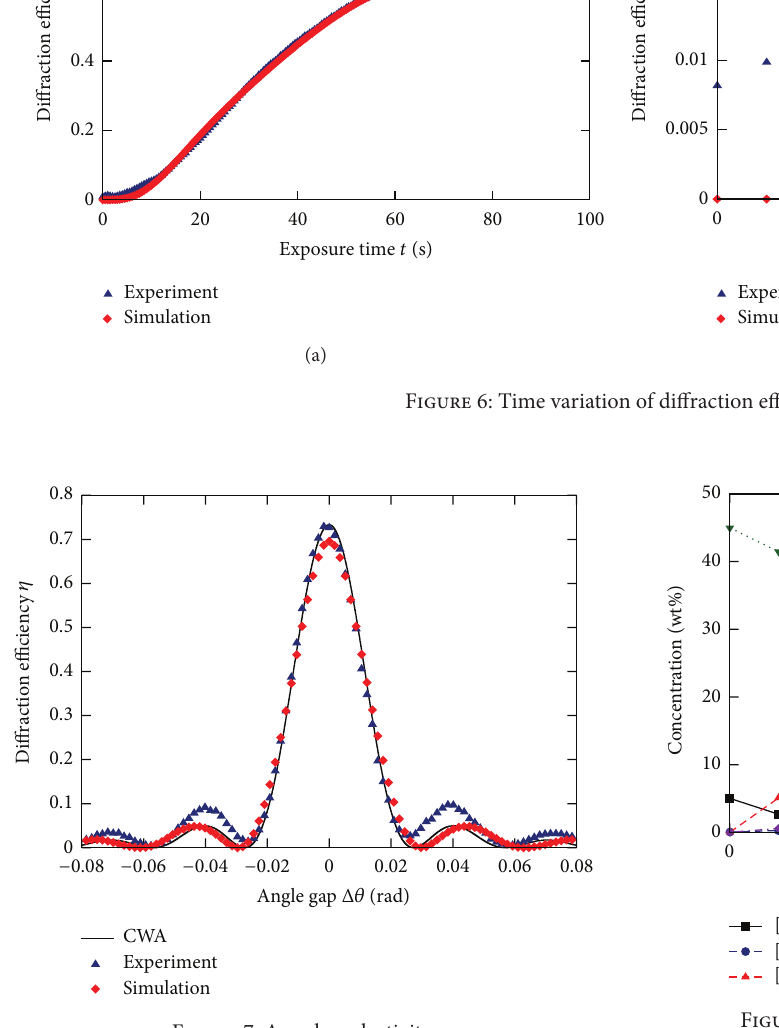
Figure 7: Angular selectivity.